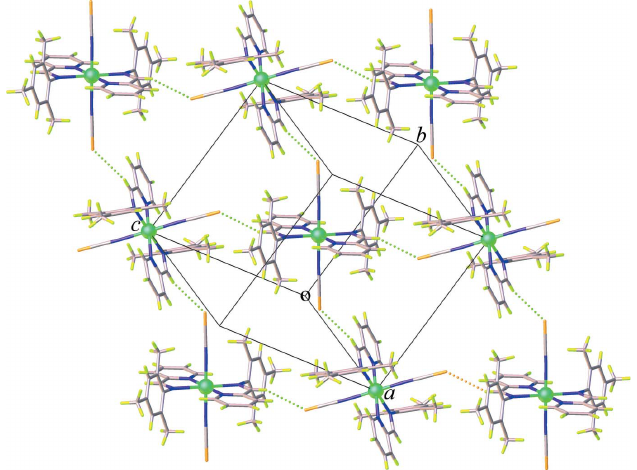
Figure 6 Formation of a two-dimensional supramolecular network in ( II )